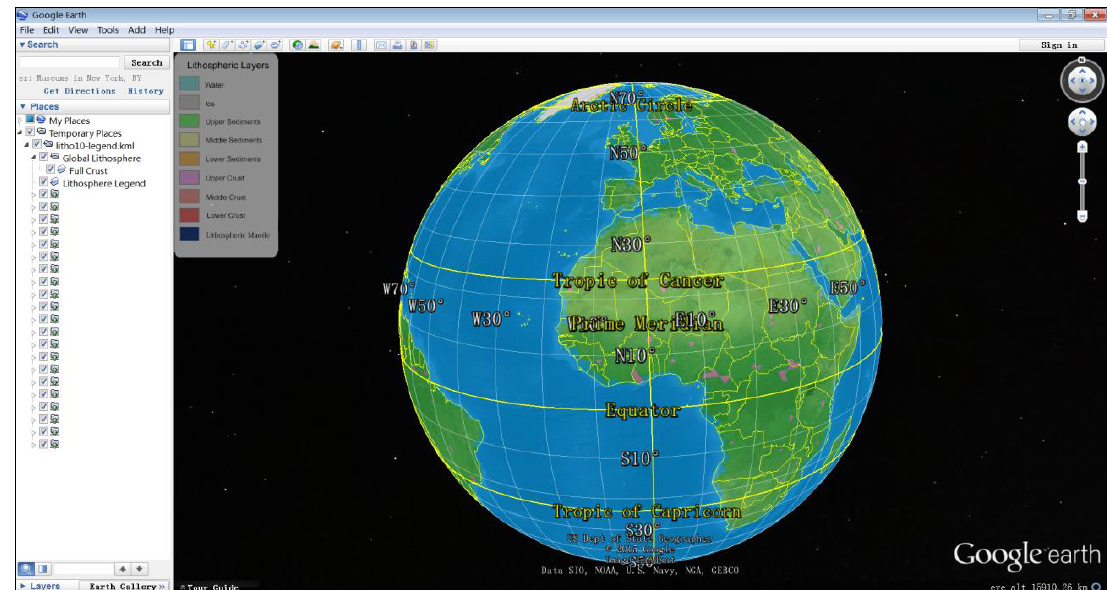
Figure 3. Displaying the global lithosphere with the simple level (LOD0) in Google Earth.